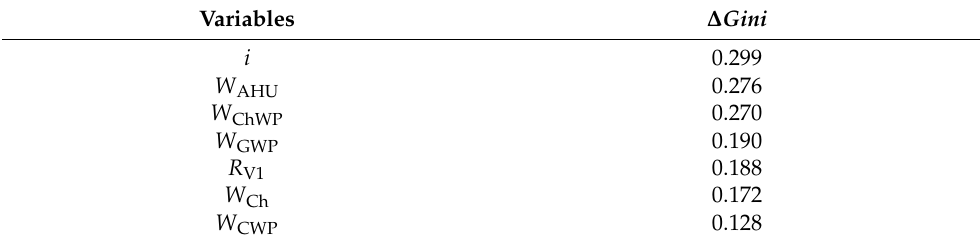
Table A3. ∆ Gini values for variables at node 0.